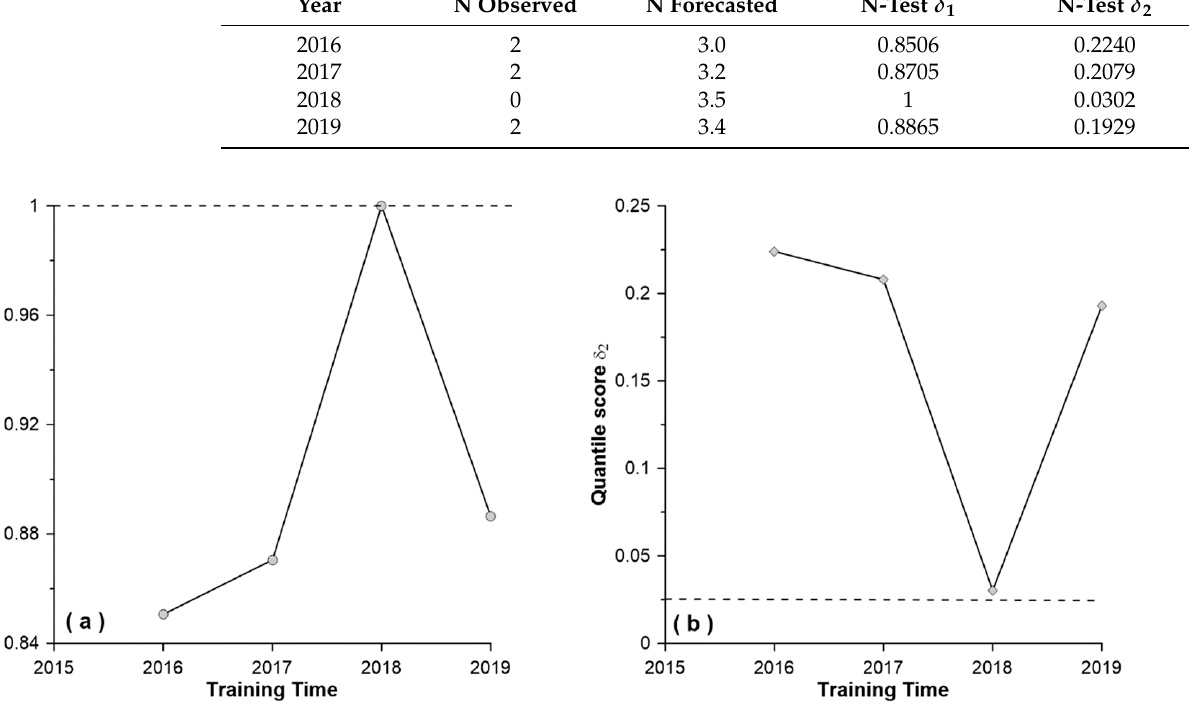
Table 5. Observed and forecasted earthquake number using the selected SSA model quantile score δ 1 and δ 2 .